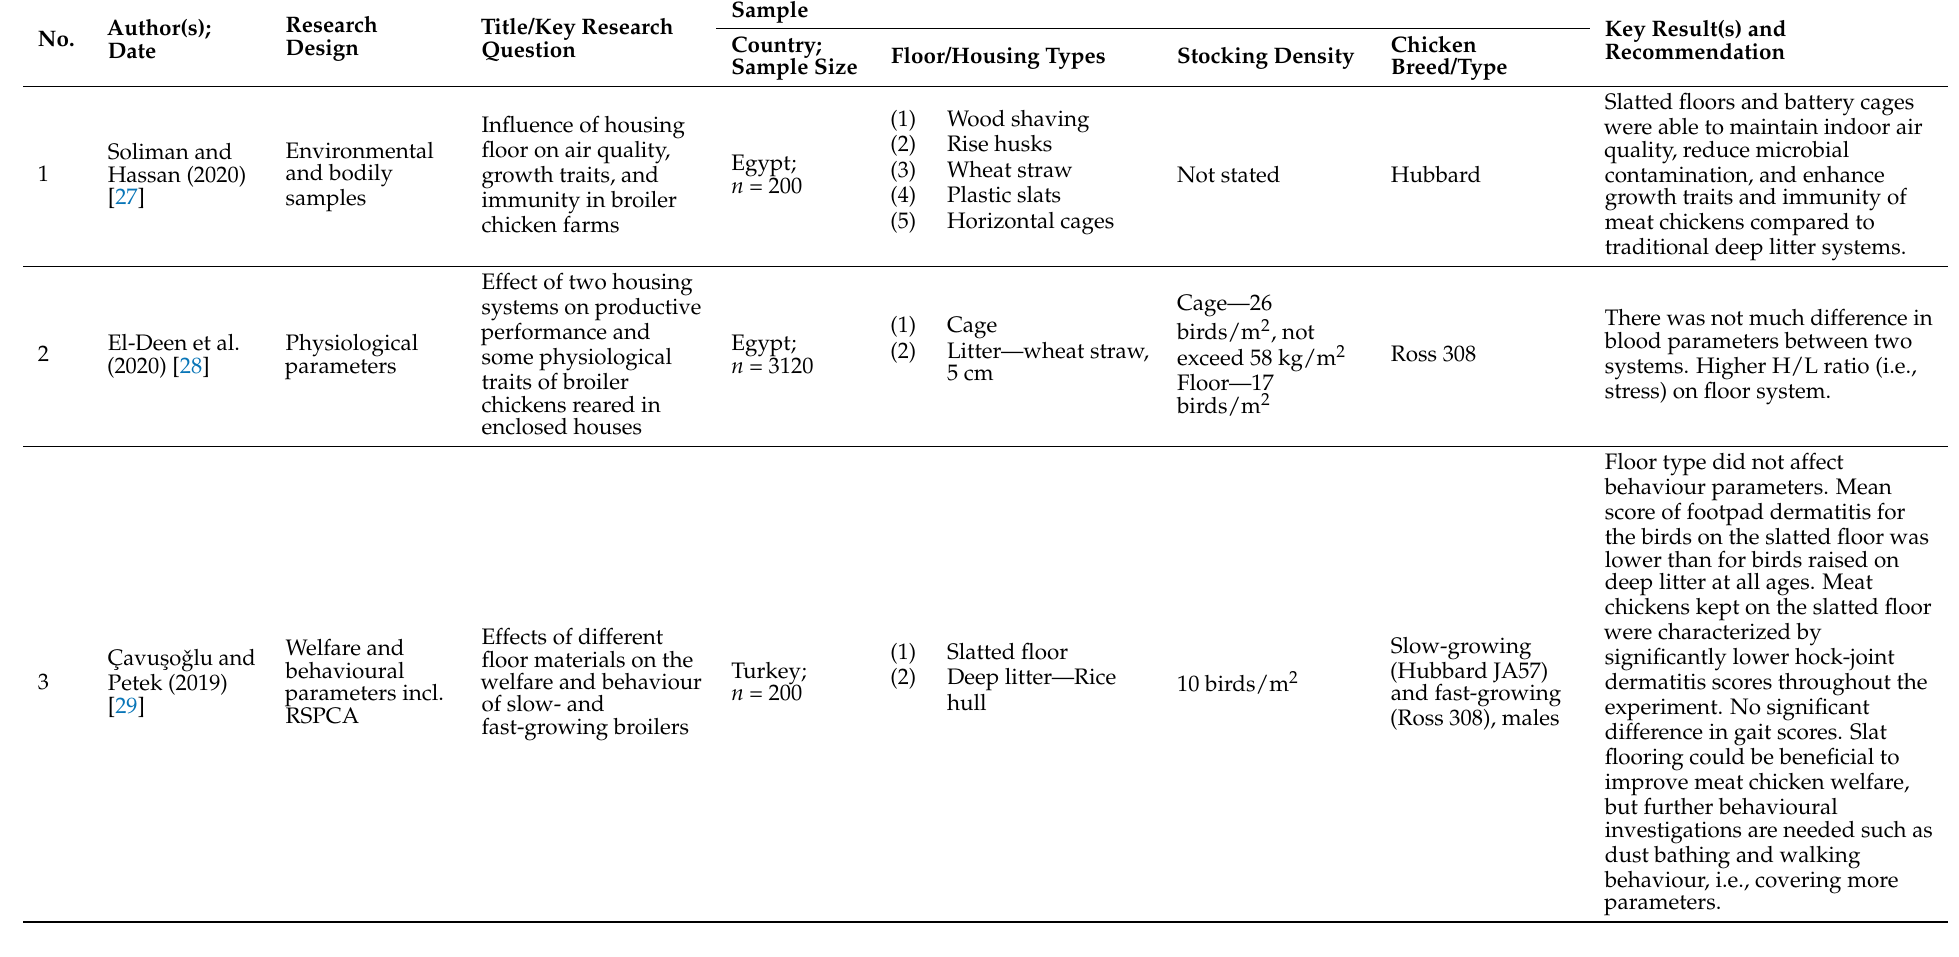
Table 2. Studies (8) suggesting no significant welfare problem using slatted floors or cages. Nb: If the material of the slatted floor was not stated, it was not reported. Stocking densities were not converted into consistent measures due to variable chicken body weights. WQA refers to Welfare Quality Assessment. Studies are